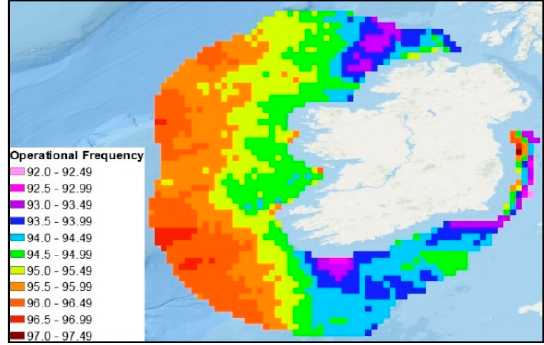
Figure 8. Operational frequency map at 80 m a.s.l. of Ireland’s waters between 20 km and 200 km from the coast derived from ASCAT-A and -B observations for the years 2013 to 2016 and ASCAT-A 2012.